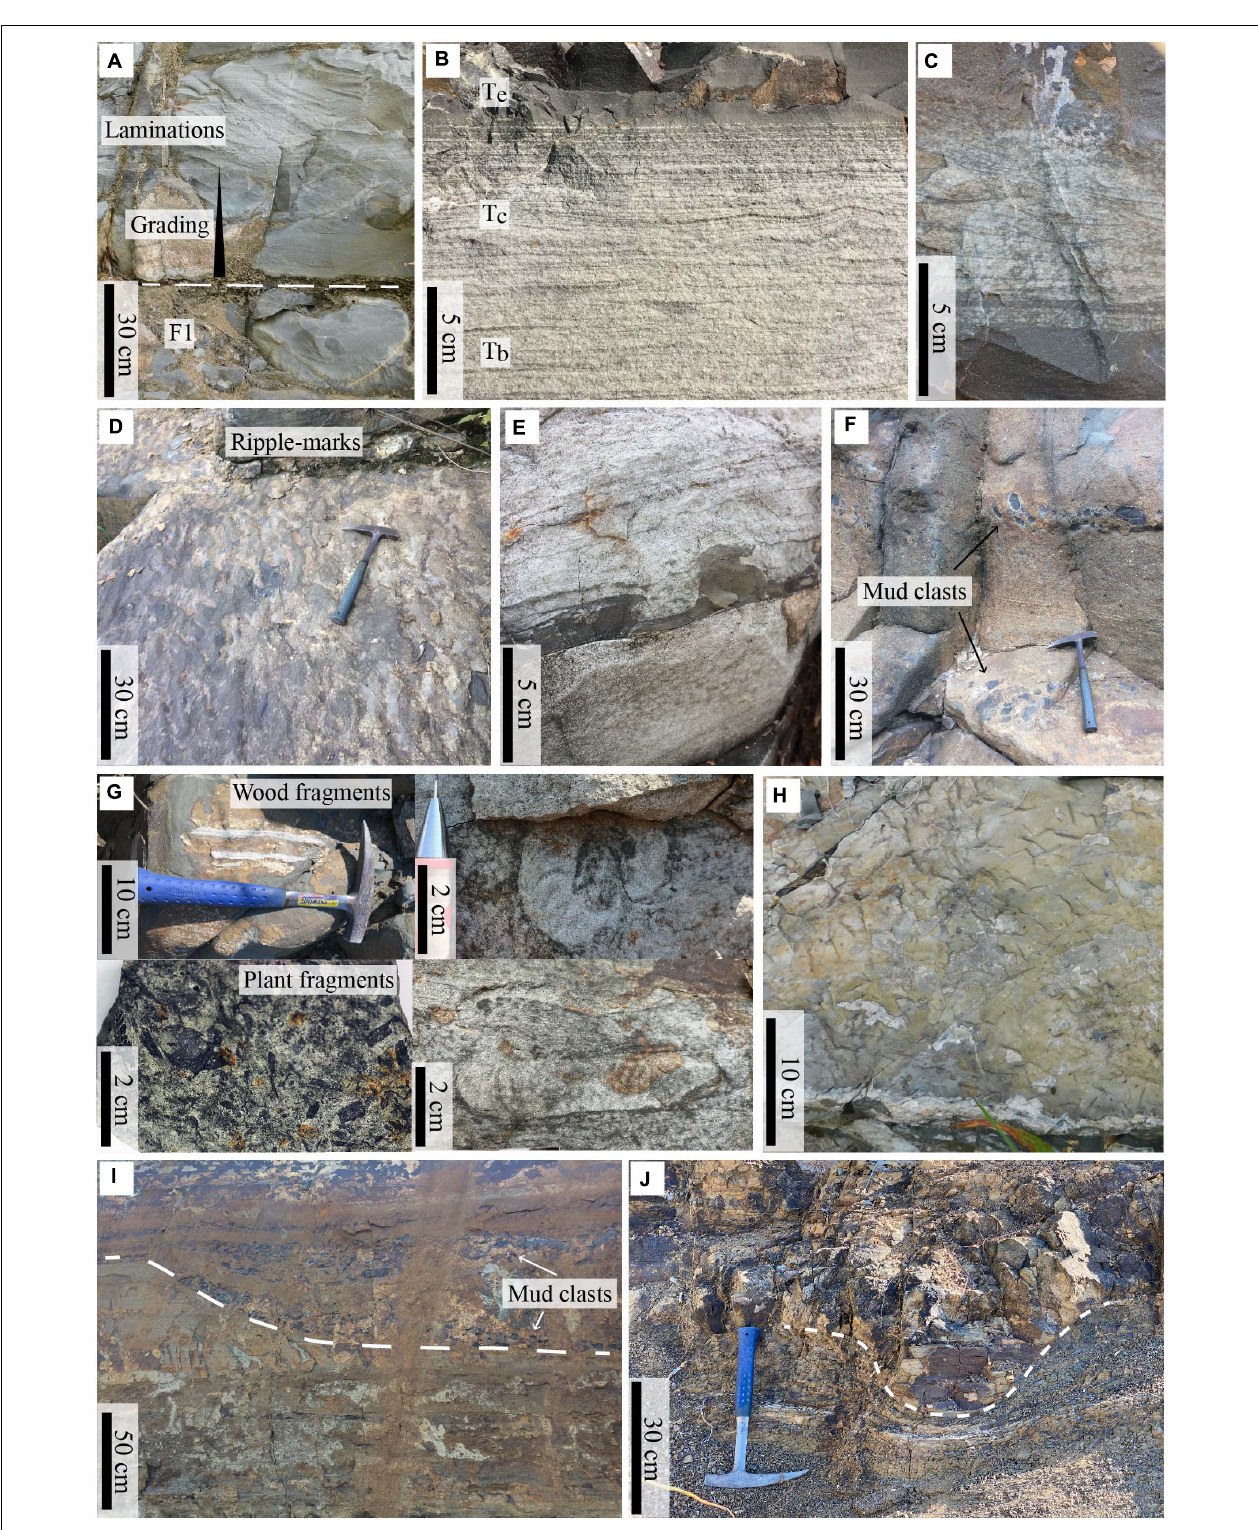
FIGURE 5 | Representative photographs of structured sandstone facies (F2). (A) Graded and laminated sandstone overlying structureless sandstone of F1. (B) Parallel (Tb) and wavy-ripple (Tc) laminations overlain by structureless mudstone (Te). (C) Small-scale trough cross laminations (D) Ripple marks observed on bedding surface. (E) Organic-rich layer with load and flame structures. (F) Mud rip-up clasts with various shape and size. (G) Wood, plant fragments and bioturbated sandstone. (H) Syneresis crack on the bedding surface. (I) Channel feature with mud clasts layers. (J) Small-scale channel-like feature.